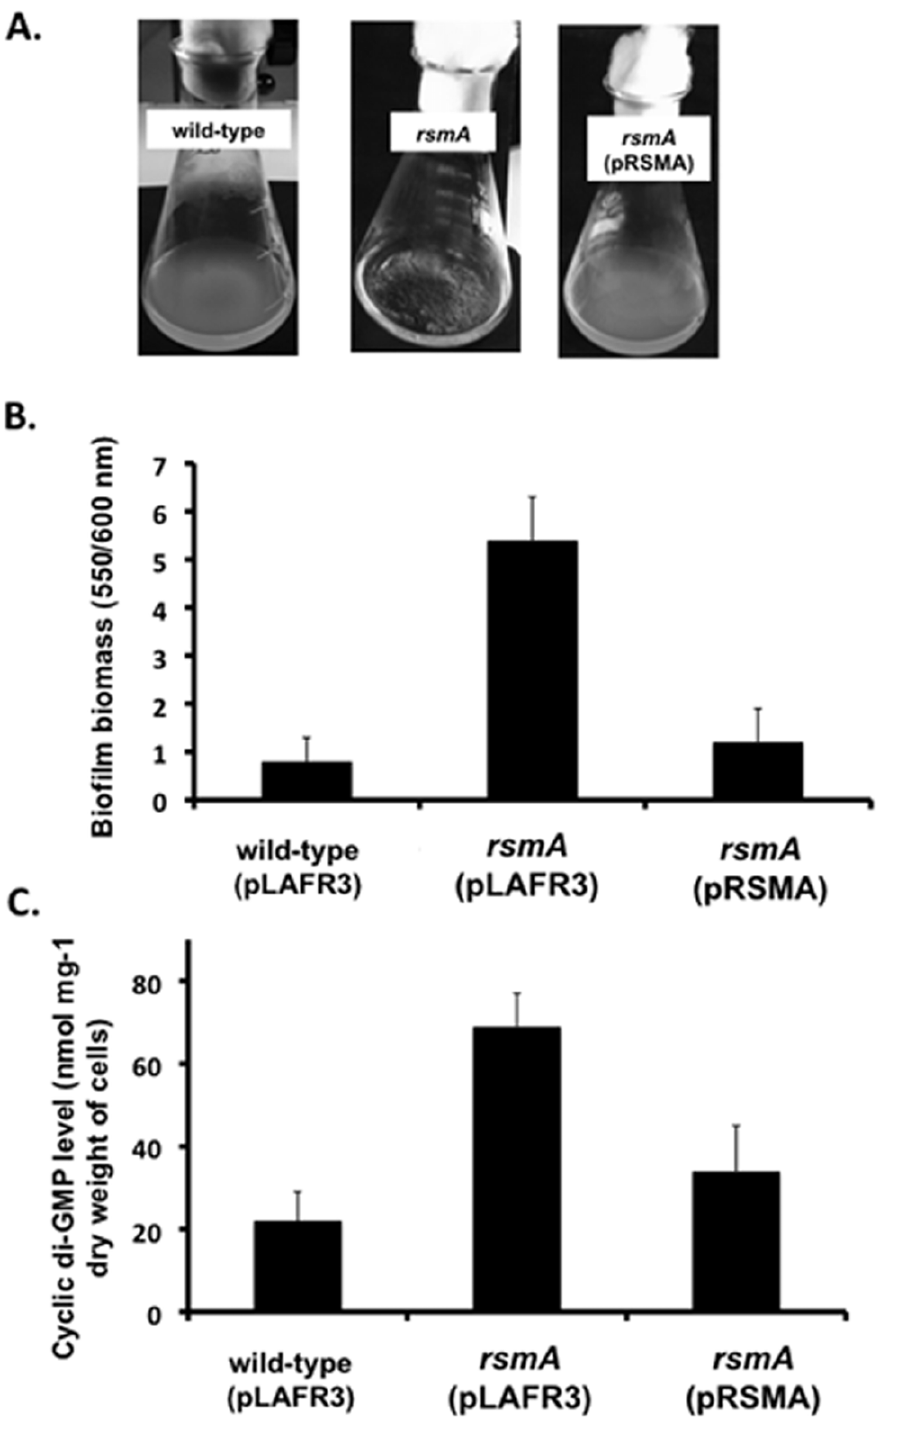
Figure 1. The rsmA mutant has an increased biofilm phenotype and is associated with an elevated intracellular level of cyclic di- GMP. (A) The rsmA mutant grows in an aggregated fashion in L medium, whereas the wild-type strain (8004) grows in a dispersed fashion. In trans expression of the gene encoding rsmA in the mutant restores the phenotype to wild-type. (B) The rsmA mutant also has increased biofilm and cell adhesion on a glass surface when assessed by crystal violet staining (see Methods for details). Values given are the mean and standard deviation of triplicate measurements. (C) Effects of mutation of rsmA on cyclic di-GMP level in Xanthomonas. Elevated levels of extractable nucleotide were seen after mutation of rsmA . Introduction of the cloned rsmA gene (pRSMA) into the rsmA mutant reduced cyclic di-GMP levels to wild-type. Values given are the mean and standard deviation of triplicate measurements (three biological and three technical replicates).